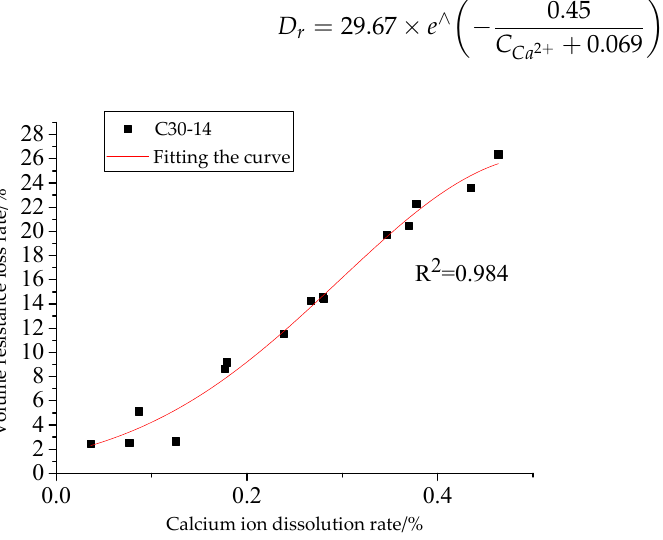
Figure 8. Relationship between calcium ion dissolution rate and volume resistance loss rate.